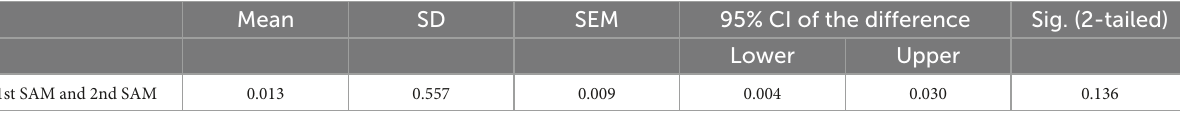
TABLE 5 Paired-samples t -test of SAM.